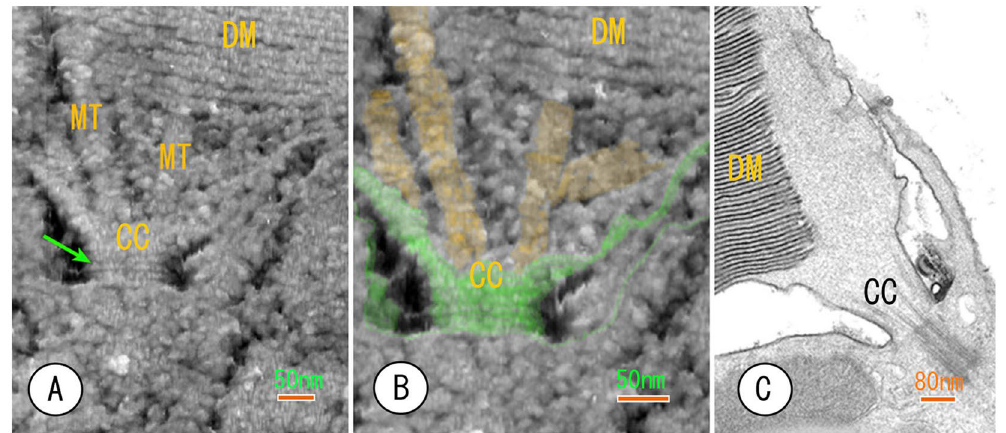
Figure 3. The AFM images of the connecting region between the outer and inner segment showing the outside and inside of the connecting cilium (CC). ( A ) The ciliary necklaces (an arrow) are exposed to the external surface of the connecting cilium because of the removal of sucrose. The upper section area contained microtubules (MT) that should be doubled in size. The finer structure of the microtubules is not observable. ( B ) The same image from A at a higher magnification. The external surfaces of the connecting cilium and microtubules are coloured in green and yellow, respectively. ( C ) A conventional thin-section EM image included as a